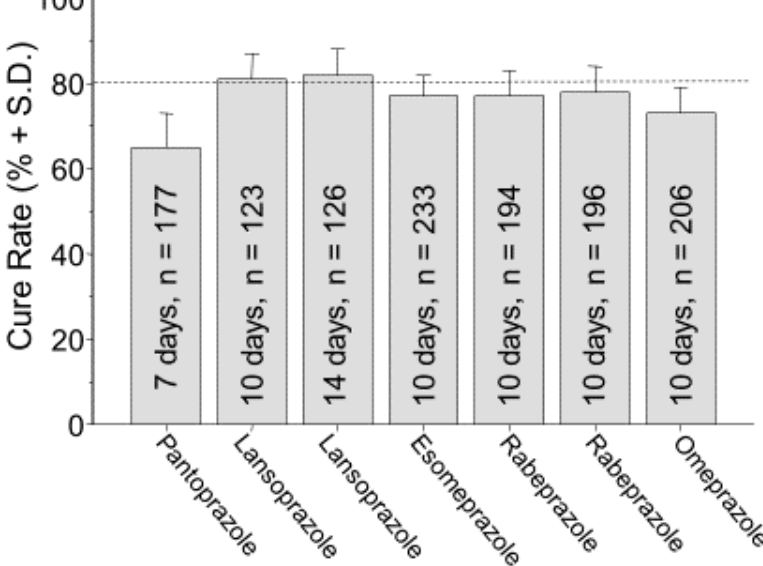
Figure 1. Intention to treat cure rates and standard deviations reported from the clinical trials published for studies designed to obtain FDA approval for triple therapy with PPI, clarithromycin, and amoxicillin, in the United States. From [4] with